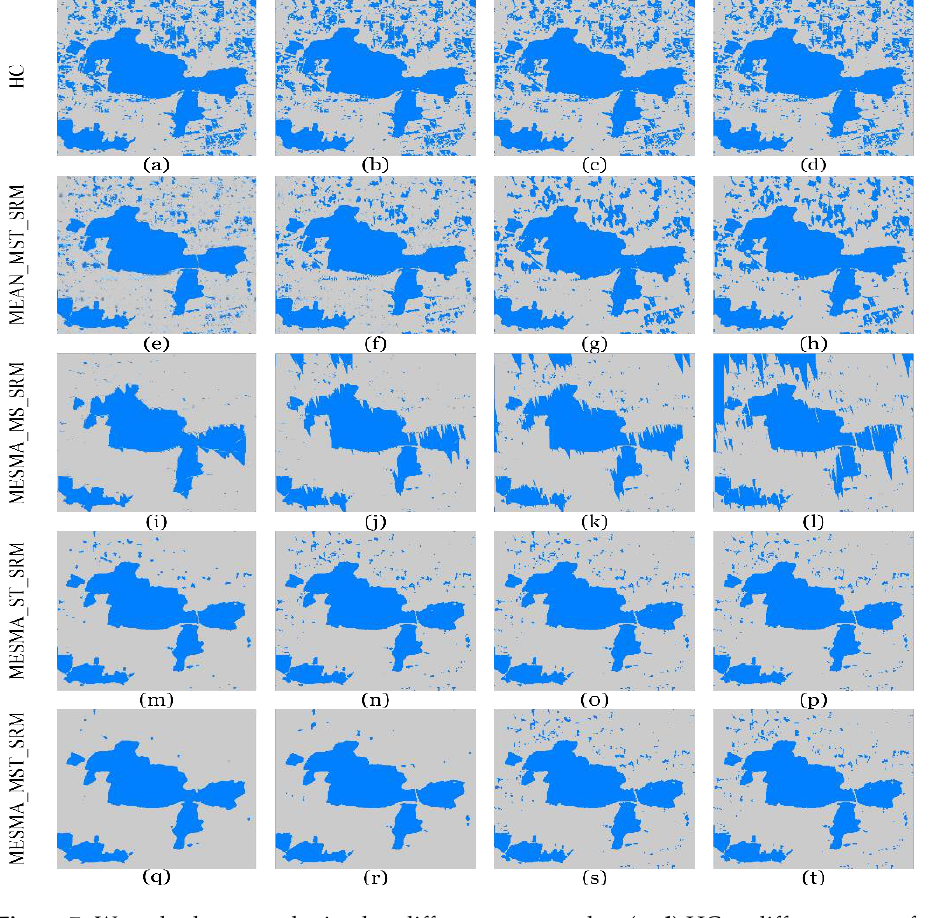
Figure 7. Water body maps obtained at different zoom scales: ( a – d ) HC at different zoom factors;